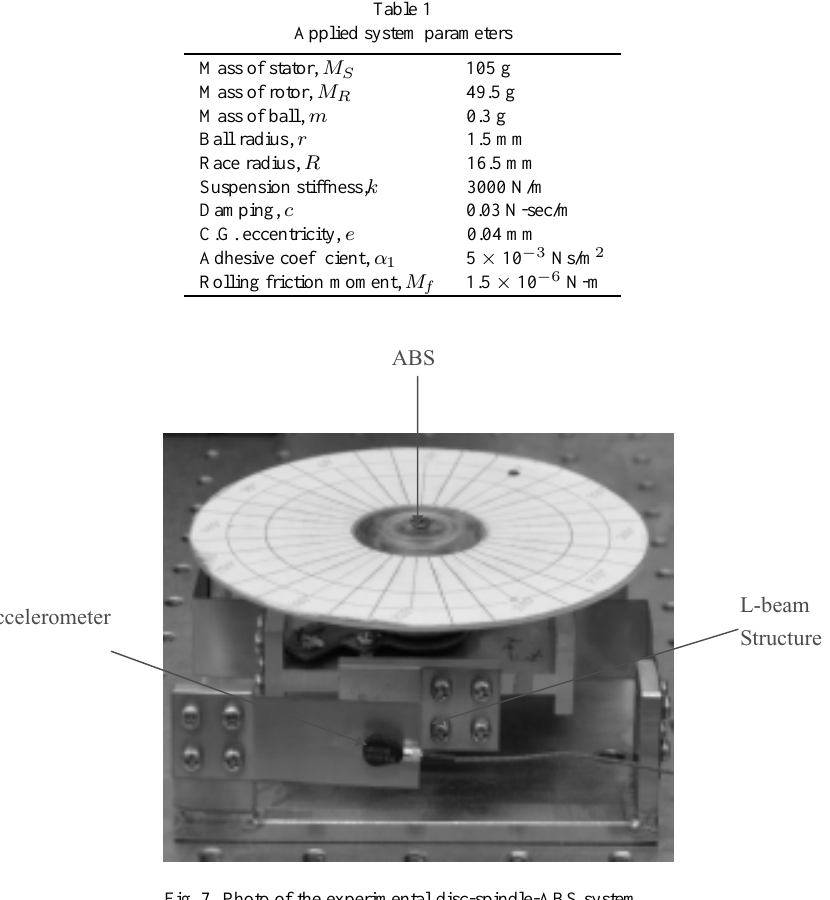
Fig. 7. Photo of the experimental disc-spindle-ABS